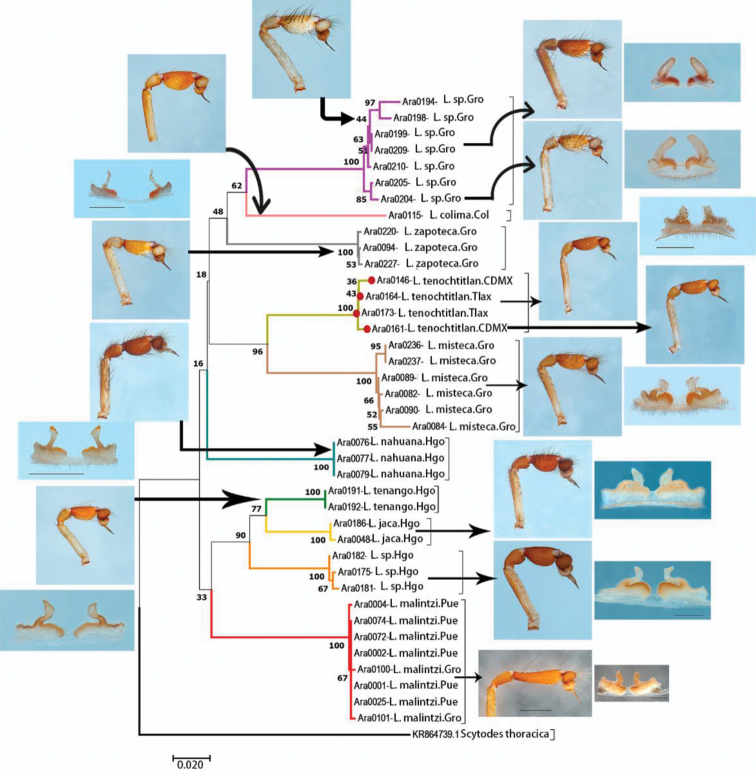
Neighbor-joining (NJ) tree constructed from COI data of ten species of Loxosceles from Mexico. Colors of branches indicate different species. Numbers on nodes are bootstrap support values. Red circles represent Loxosceles
tenochtitlan sp. nov.